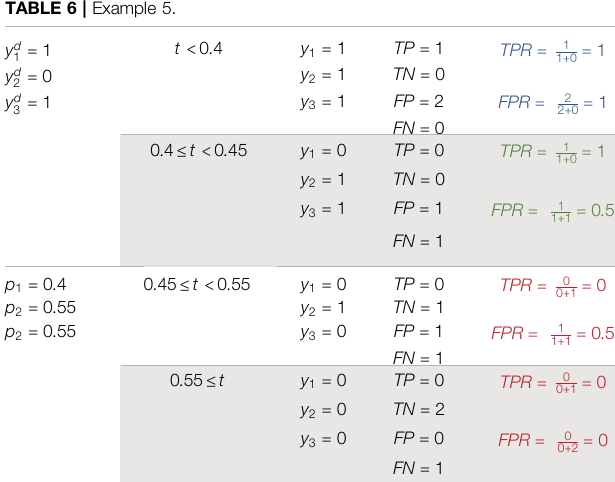
TABLE 6 | Example 5.